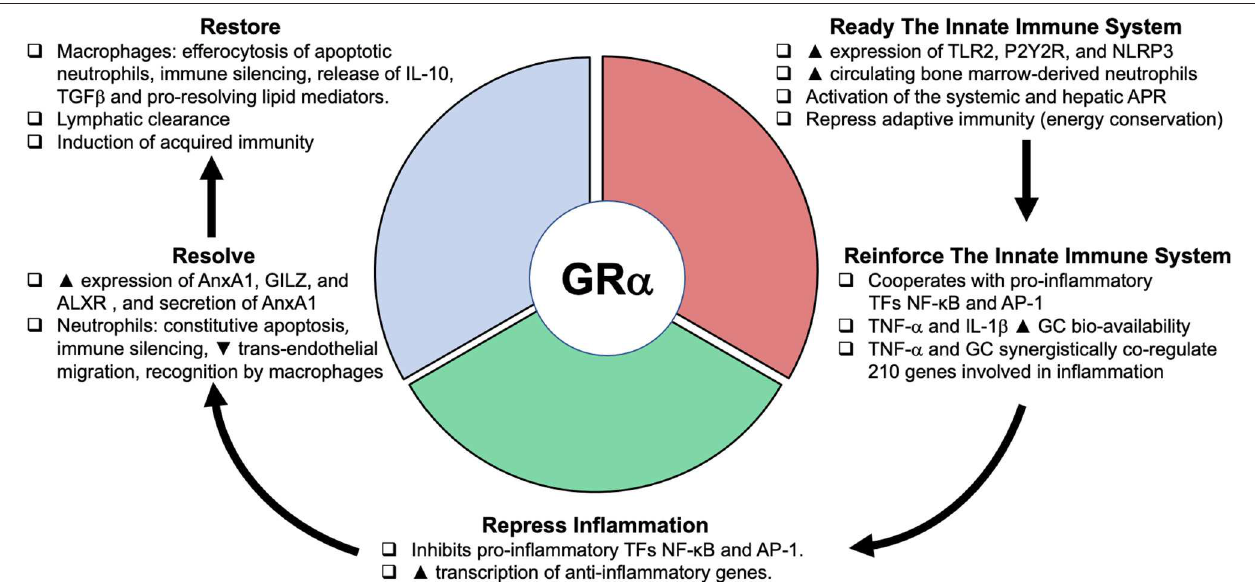
FIGURE 3 | Glucocorticoid receptor α as cellular rheostat of homeostatic corrections. The glucocorticoid receptor α (GR α ) acts as a cellular rheostat to ensure that a proper response is elicited by the neuroendocrine immune system throughout the three phases of homeostatic corrections: the pro-inflammatory (ready- reinforce), the anti-inflammatory (repress), and the resolution (resolve- restore) phase. Modified with permission from Busillo and Cidlowski ( 92). TLR2, toll-like receptor 2; purinergic receptor P2Y2R; NLRP3, NOD-like receptor pyrin containing 3; APR, acute phase response; TF, transcription factor; NF- κ B, nuclear factor- κ B; AP-1, activator protein 1; AnxA1, annexinA1; ALXR, AnxA1 receptor; GILZ, glucocorticoid-induced leucine zipper; TGF β , transforming growth factor β